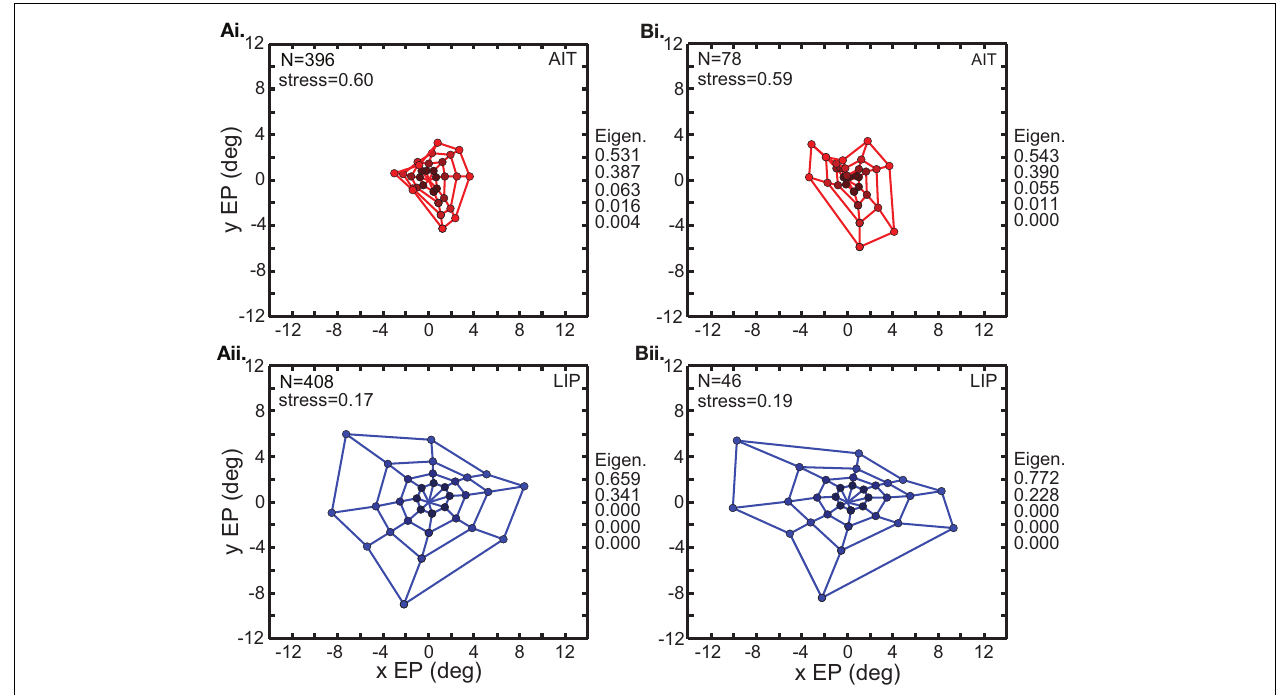
FIGURE 4 | Two variations of the multidimensional scaling analyses in Figure 3. Conventions are the same as in Figure 3 , with red points indicating results from AIT and blue points results for LIP. (A) Recovery of eye positions from neural population activity, using single-trial results rather than mean results across trials. Each single-trial response for a